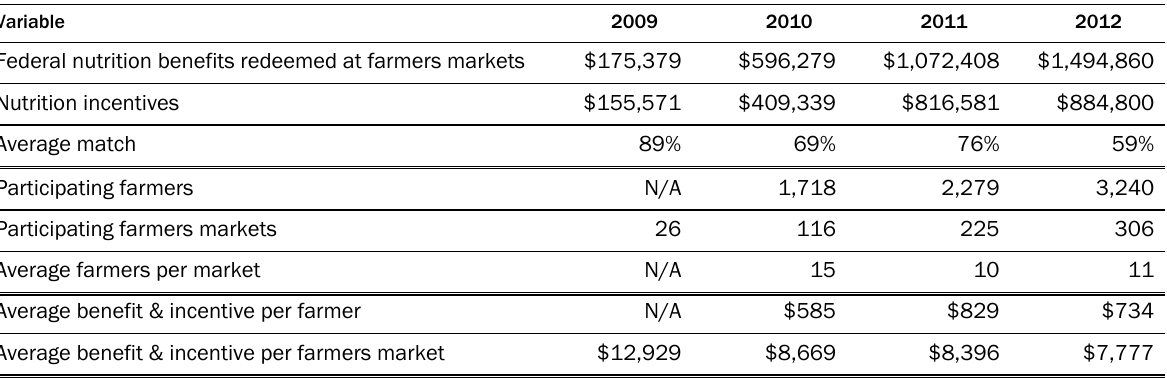
Table 1: Federal Nutrition Benefits, Nutrition Incentives and Participating Farmers Markets: Wholesome Wave, 2009–2012 (all dollar values in US$)